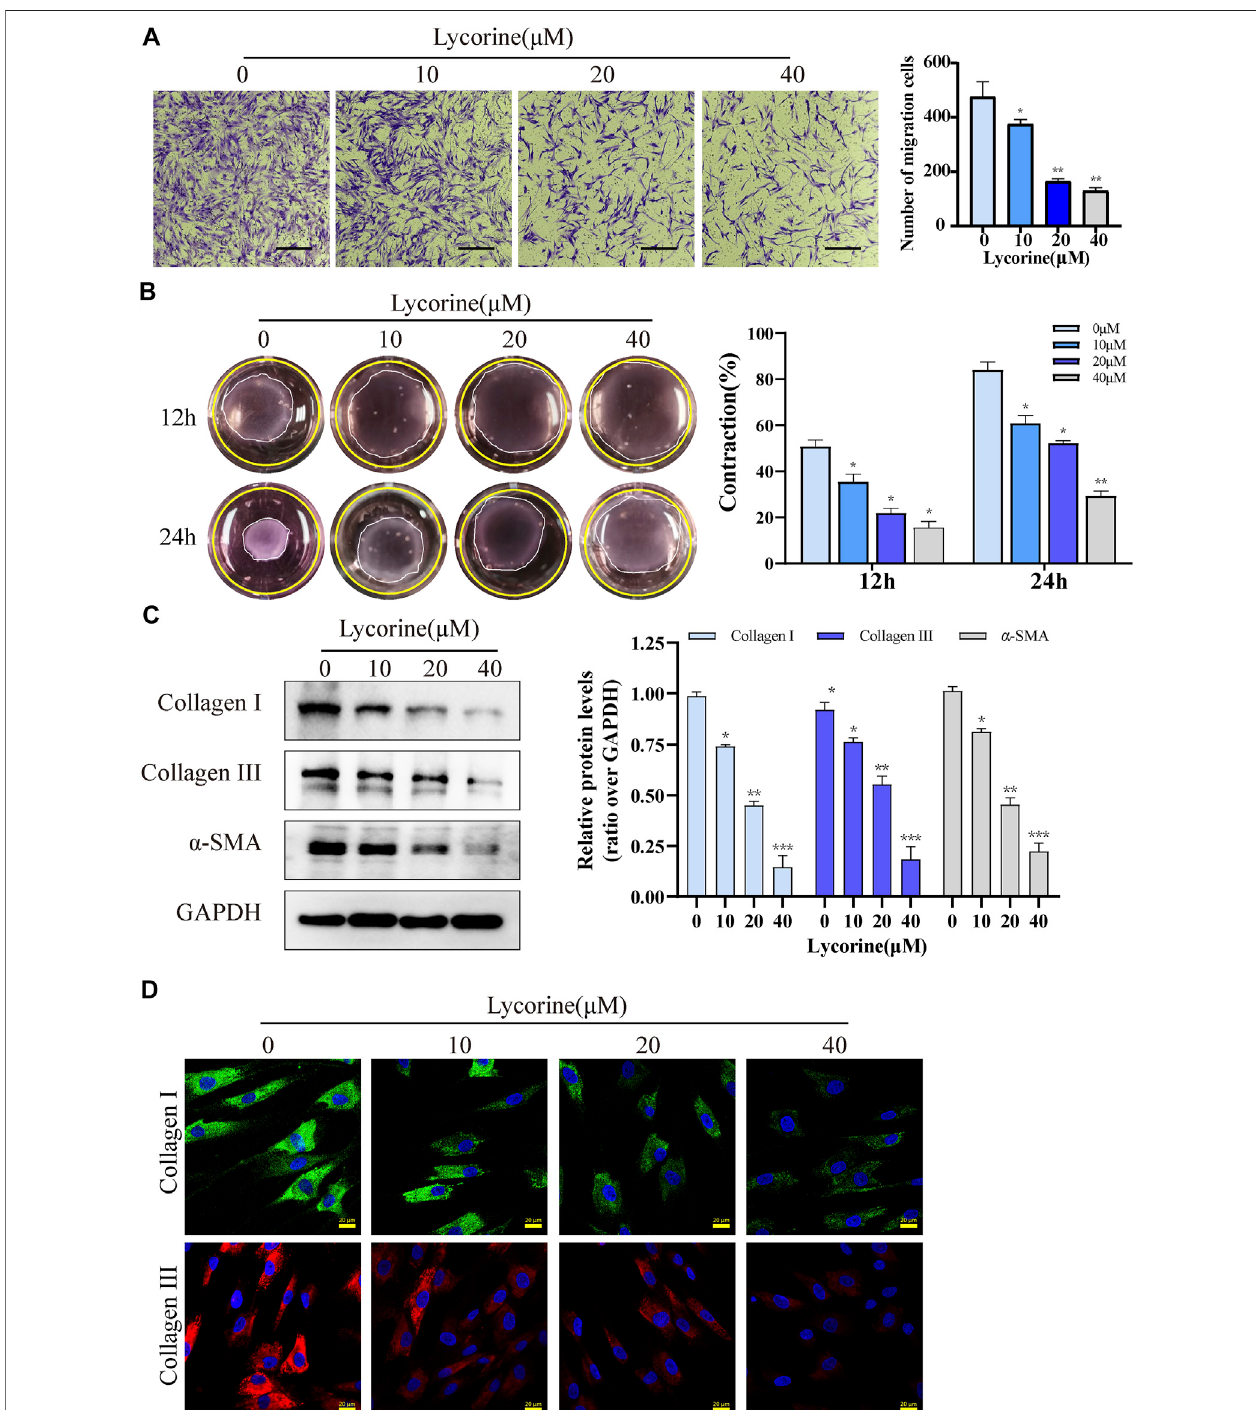
FIGURE 3 | Lycorine inhibits the migration and contraction of HSFs by reducing their production of fi brotic factors. HSFs were treated with vehicle or lycorine at indicatedconcentrations. (A) Transwell migrationassaysindicatedthatlycorine treatment for24 hinhibited themigrationofHSFs( n =3).Scalebar =200 mm. (B) HSFs weremixedwithrattailcollagen,andthecollagengeslwereimagedat12and24 hlater( n =3). (C) At24 hpostlycorinetreatment,therelativelevelsofa-smoothmuscle actin (a-SMA), collagen I, and collagen III expression were determined by Western blot ( n = 3) and (D) the levels of collagen I, collagen III expression were analyzed by immuno fl uorescence ( n = 4), Scale bar = 20 μ M. Data are mean ± standard error of the mean. * p < 0.05, ** p < 0.01, *** p < 0.001.